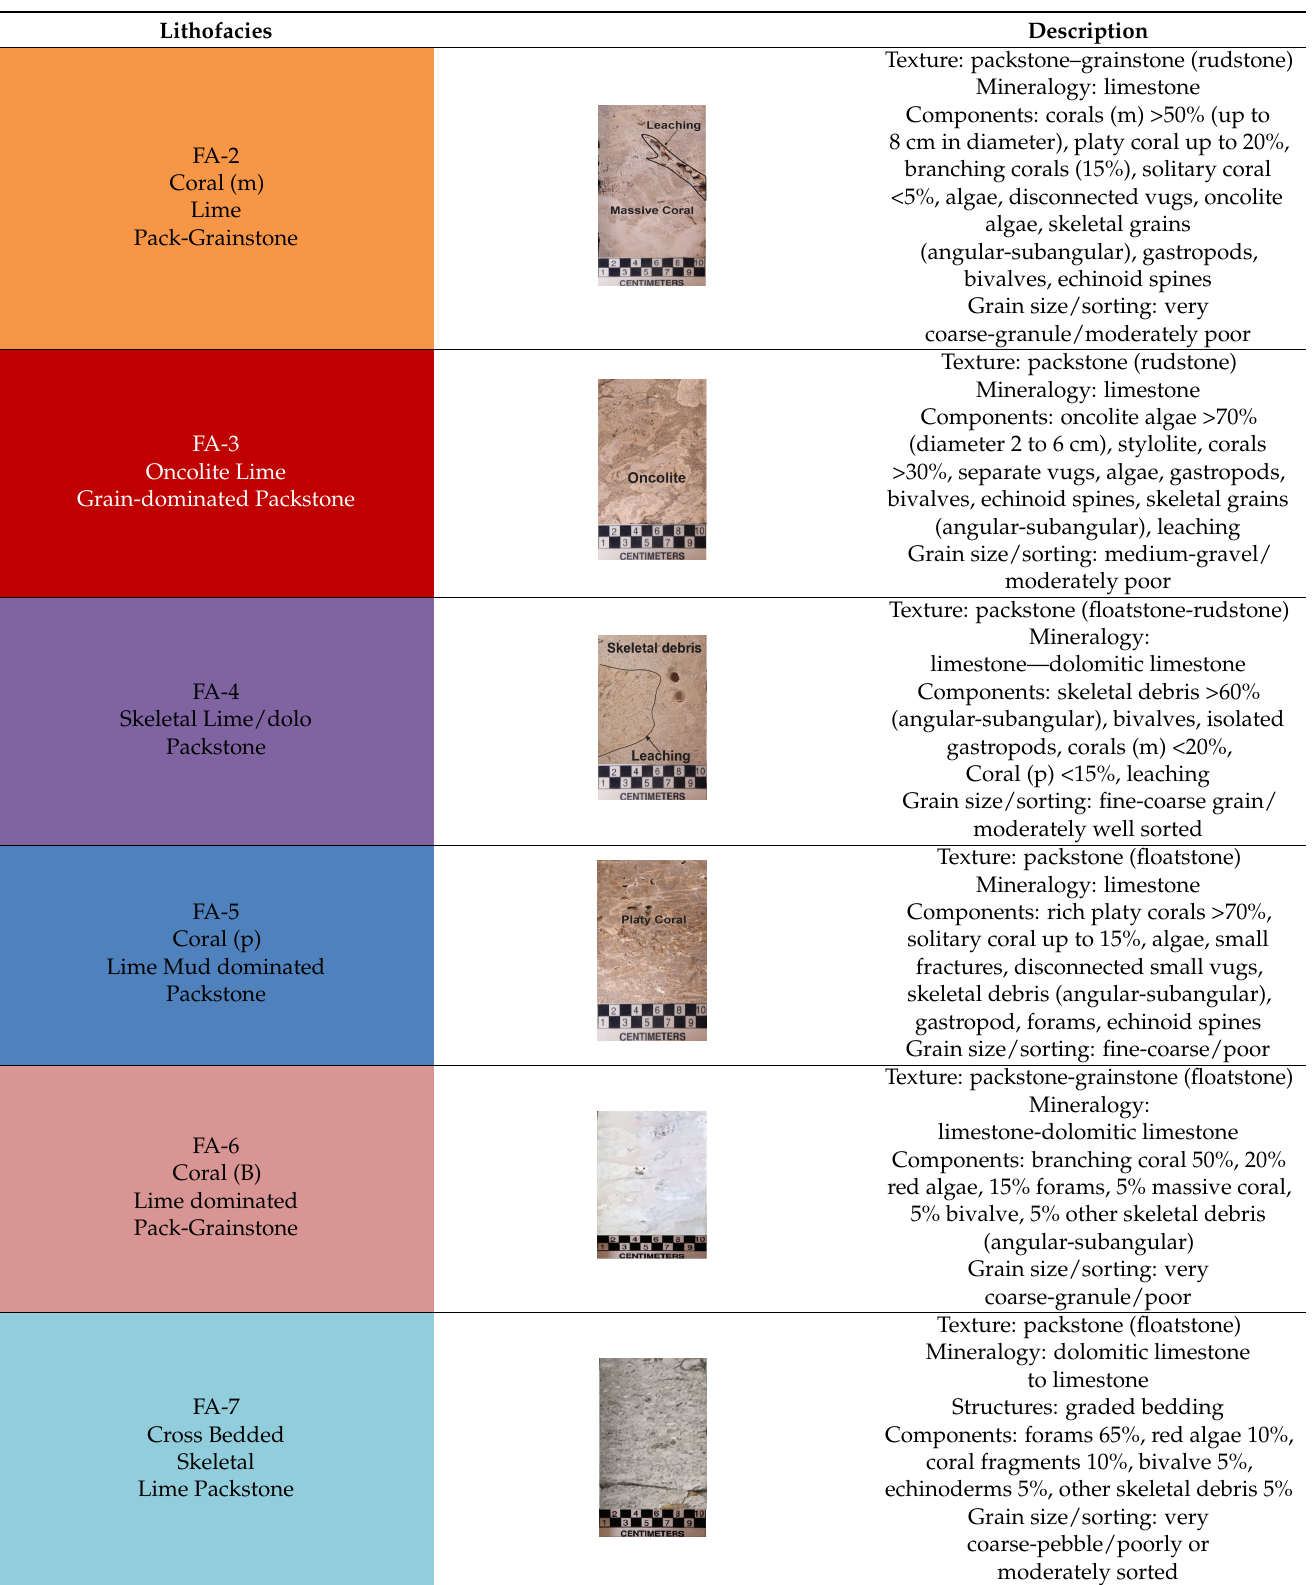
Table 5. Lithofacies for Central Luconia carbonates based on depositional texture and wireline-log response (adopted from Janjuhah et al. [9] ).